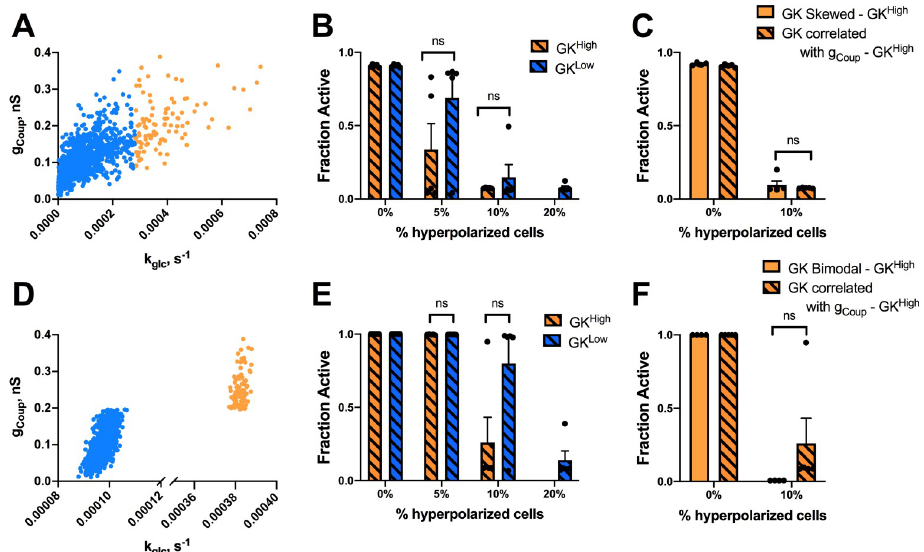
Fig 3. Simulations predicting how changes in coupling impact highly metabolic populations. A). Scatterplot of g Coup vs. k glc for each cell from a representative simulation where g Coup is correlated with k glc under a skewed distribution in GK activity. B). Fraction of cells showing elevated [Ca 2+ ] activity (active cells) vs. the percentage of cells hyperpolarized in islet from skewed simulations in k glc with correlated g Coup and k glc as in A. Hyperpolarized cells are chosen either from GK High (orange bars) or GK Low (blue bars) population. C). As in B. but comparing hyperpolarization in GK High cells in the presence and absence of correlations in g Coup . D). as in A but from a simulation where g Coup and k glc are correlated under a bimodal distribution in GK activity. E). As in B. but for simulations where g Coup and k glc are correlated under a bimodal distribution in GK activity. F). As in C. but comparing hyperpolarization in GK High cells in the presence and absence of correlations in g Coup under a bimodal distribution in GK activity. Error bars are mean ± s.e.m. Student’s paired t-test was performed for B and E and a Welches t-test for unequal variances was used for C and F to test for significance. Significance values: ns indicates not significant (p > .05), � indicates significant difference (p < .05), �� indicates significant difference (p < .01), ��� indicates significant difference (p < .001), ���� indicates significant difference (p < .0001). Data representative of 4 simulations with differing random number